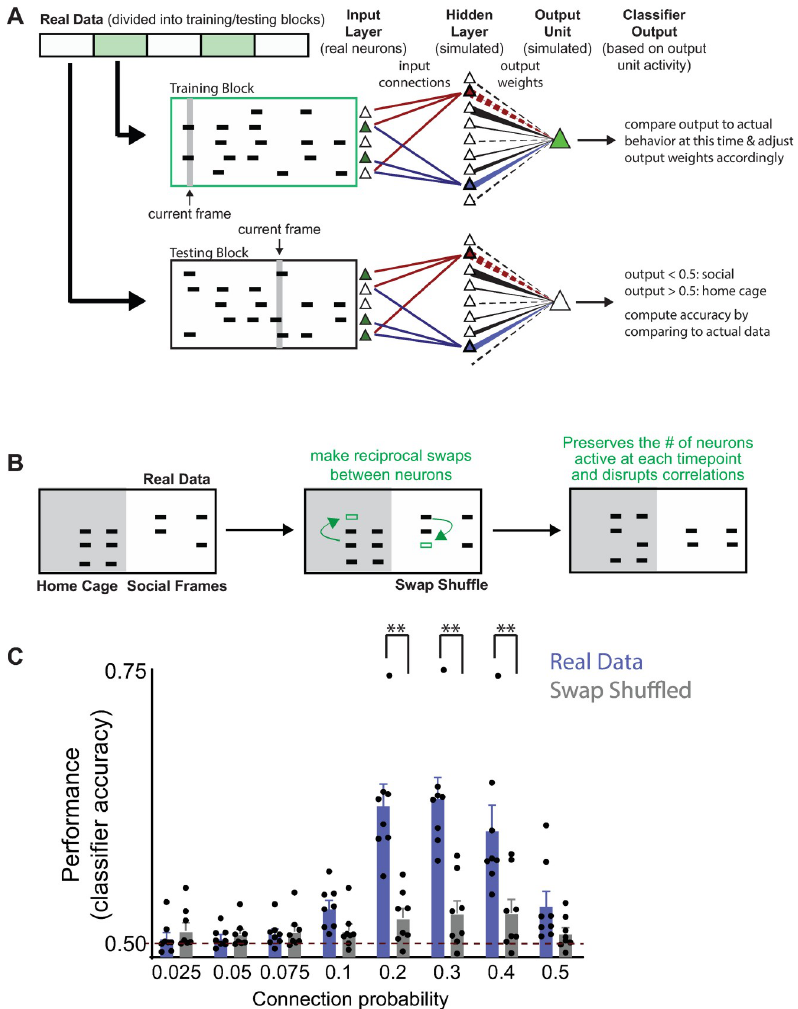
Fig 2. Classifying behavior from prefrontal ensembles using a simple neural network. (A) We constructed a neural network consisting of a single hidden layer (containing 1,000 units) connected to a single output unit. The thickness of lines between each hidden layer unit and the output unit reflects the magnitude of the output weight. Positive and negative weights are indicated by solid and dashed lines, respectively. Each hidden layer unit received input from a random subset of prefrontal neurons from one real dataset. For clarity, we have only shown input connections to 2 hidden layer units (which are differentiated by their blue and red colors)—output weights from other hidden units are shown in black. The output weight from each hidden layer unit was iteratively updated during training. We trained the classifier to distinguish periods marked as HC exploration or social interaction by dividing a dataset into 500-frame blocks and then using alternating blocks for training or testing. (B) Cartoon describing swap shuffling procedure. Note that in this figure, we swapped events between neurons and across the entire dataset, thereby disrupting behavior- specific changes in the activity levels of individual neurons, while preserving both the total activity for each neuron (over the entire experiment) and the number of neurons active in any given frame. (C) The classifier performed poorly (near chance) when the input connection probability (governing the number of prefrontal neurons that provided input to each hidden layer unit) was < 10%. Classification accuracy was above chance in 8/10 mice and increased to a peak of 69 +/ − 3% in these mice, before decreasing again for connection probabilities > 30%. The classifier performance was significantly decreased to near-chance levels when we trained and tested using data that had been randomly swap shuffled (2 way RM ANOVA shuffle vs. real p < 0.0005; connection p < 0.0001, interaction p < 0.0001; follow-up with Bonferonni AU : PleasenotethatasperPLOSstyle ; testsshouldnotbeinpossessiveform : multiple comparisons test revealed significant differences for input connection probabilities of 20%, 30%, and 40% at p < 0.01). Data used to generate this figure can be found in the Supporting information Excel spreadsheet (S1 Data). HC, home cage; RM ANOVA, repeated measures analysis of